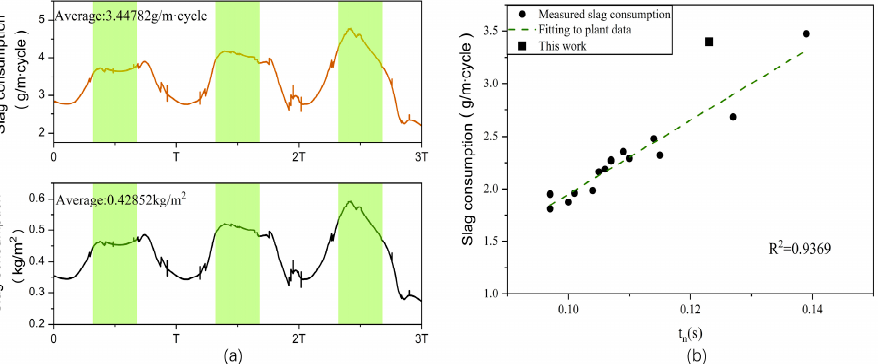
Figure 4. Comparison of slag consumption: ( a ) transient slag consumption, ( b ) comparison of predicted slag consumption with measurements from Shin et al.’s data from [26].